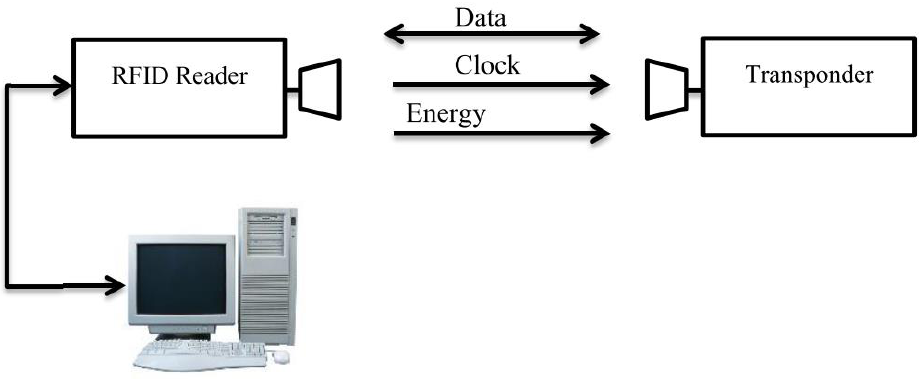
Figure 27. A basic description of the RFID system. (Reprinted from ref. [135]). RFID is similar to a barcode technology, in terms of the data transferred, but does not require line of sight. The reader has a microcontroller, signal generator and a signal receiver/detector and an antenna for each. Passive tag systems have an antenna, a transpon- der, rectifier circuit, controller and memory. LF (Low Frequency), HF (High Frequency) and UHF (Ultra High Frequency) frequencies can all be used for the operation of the tag depending on various requirements. The higher the frequency the greater the distance of detection and depending on the frequency the type of coupling that is employed changes. LF and HF works on inductive coupling (near field coupling) where the reader powers the tag, synchronisation of clock and a carrier for return data. The field emitted by the reader couples with the tag and a voltage is induced; this is used as power for memory access. When a load is connected the impedance can be used to change current and hence the rate of change of current can be used to create a voltage. The load can be controlled and switched on and off to create binary communication and hence changes voltage across tag coil affecting the carrier wave of the reader. High frequency can be read from approximately 0.8 m but is generally a cheaper solution